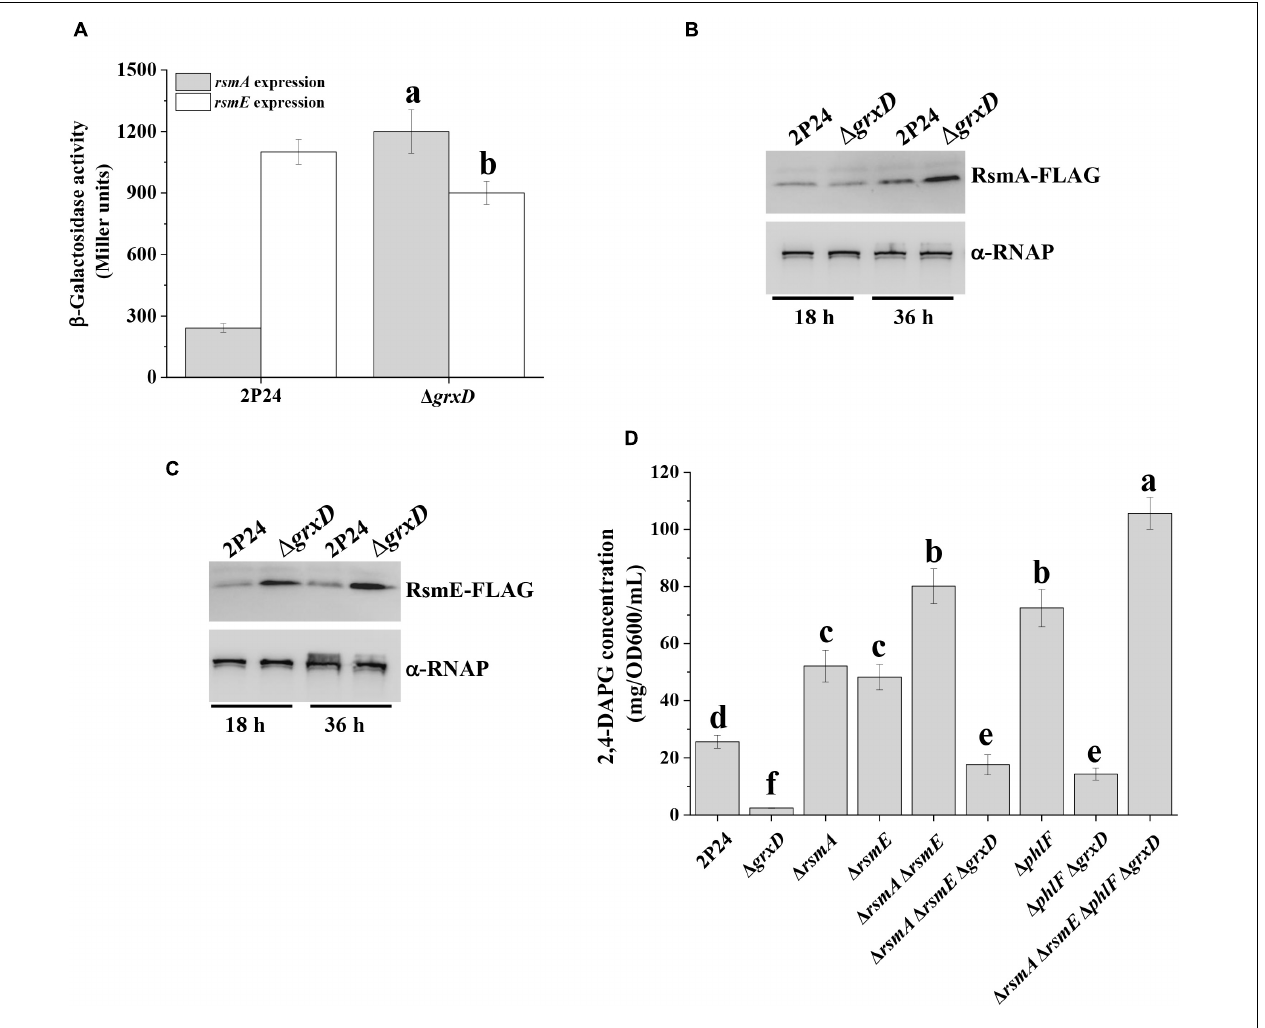
FIGURE 2 | GrxD influenced the levels of RsmA and RsmE proteins. (A) The β -galactosidase activity of rsmA (cid:48) - (cid:48) lacZ and rsmE (cid:48) - (cid:48) lacZ translational fusions was determined in strain 2P24 and its grxD mutant at 36 h after inoculation. Analysis of RsmA-FLAG (B) or RsmE-FLAG (C) levels in total crude lysates prepared from strain 2P24 and its grxD mutant. An antibody directed against RNA polymerase β subunit ( α -RNAP) was used as a loading control in this and later assays. Quantification of the production of 2,4-DAPG (D) from strain 2P24 and its derivatives. All experiments were performed in triplicate, and different letters indicate a significant difference at the 0.05